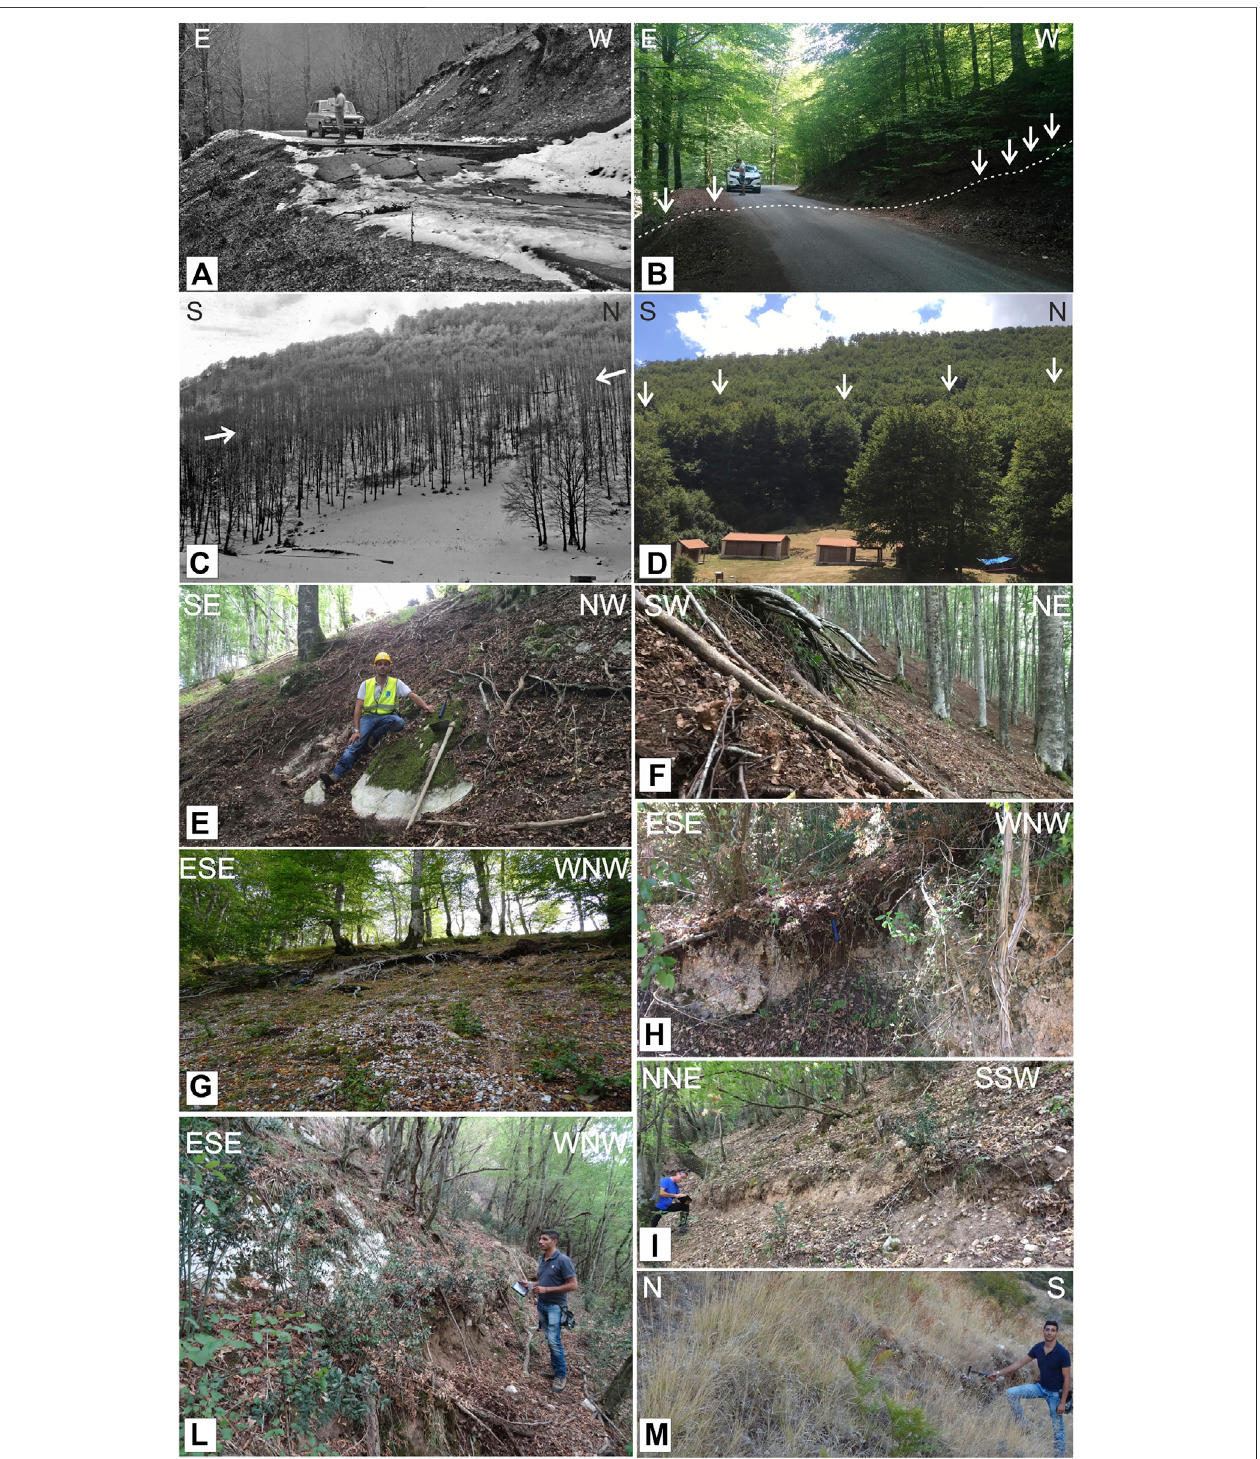
FIGURE7 | CoseismicruptureevidencealongtheIFandAFA.Locationin Figure8A . (A) TheroadthatcoastthePianodiPecoreonMarzanoMt.withsurfacefaulting ofabout1meter. (B) Therestorationoftheroadsurfacehaserasedthetracealongtheroadofthecoseismicrupture,butthelatterremainsevidentatitsedges(blackarrows). (C) CoseismicrupturealongtheMarzanoMt.slopeinJanuary1981. (D) Panoramicviewofthefaultescarpmentthathighlightstheshadowthatthetreesonthehangingwall exposeonthetreesonthe footwallduetothe coseismicruptures (whitearrows). (Aand C) arephotographs ofI.Sgrosso publishedbyGalli and Peronace, 2014and (B,D) arephotographstakeninthesameplaces40 yearslaterduringour fi eldcampaigns. (E) CoRswiththebedrockfaultplaneoutcropping(MarzanoMt.). (F) Rootscutby the1980rupturesalongtheMarzanoMt.slope(detailsinthetext). (G) CoRsaffectingtheslopeclosetotheMelaralocality(Melarafaultsection). (H) CoRsinthebrecciasatthe southern edge of the PSGM basin (PSGM fault segment). (I, L) CoRs along the Ripa Rossa – Balvano segment affecting the slope debris at the base of the bedrock, or by fracture in soils and colluvium (details in the text), with vertical separations up to 1 m. (M) Rupture in the slope deposits with ∼ 20 cm offset along the slope ofMonticello Mt.